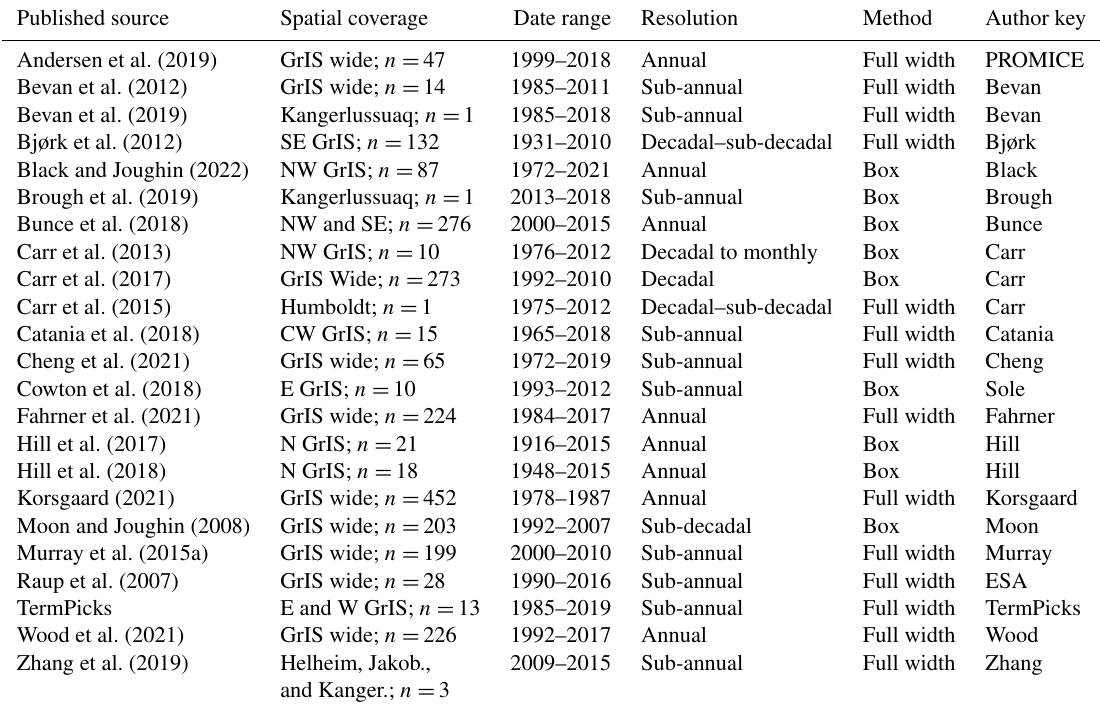
Table 1. Original sources for terminus traces for the TermPicks data set. Spatial coverage describes the number of glaciers and name/region(s) of the traces. Date range are the years covered by the data set. Resolution is the temporal resolution; annual is approximately one trace per year, sub-annual is more than one trace per year, decadal is approximately one trace every 10 years, and sub-decadal is more than one trace every 10 years but not each year. Method is the tracing method used by the author to digitize the terminus. The author key is the label given to that data set in the TermPicks data